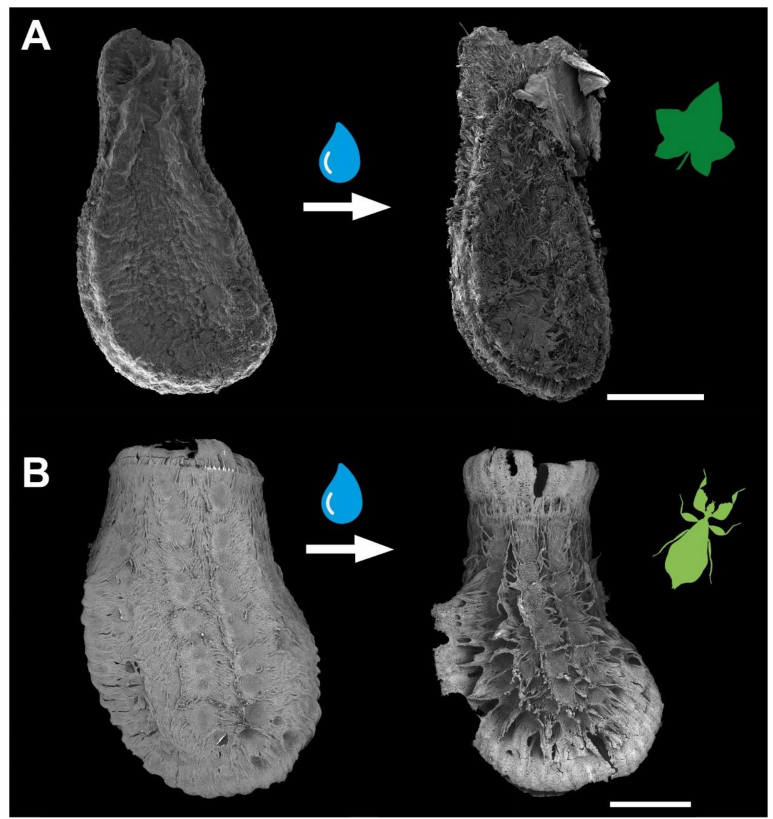
Figure 2. Water interactions of both adhesive systems. ( A ) Seed of Coccinia grandis . ( B ) Egg of Phyllium philippinicum (modified from [15] published under CCBY 4.0). The surface structures of both organisms are densely packed. Water contact induces the spreading of fibrillary adhesive structures, which carry glue for triggering adhesion in contact with the substrate. Scale bars: 1